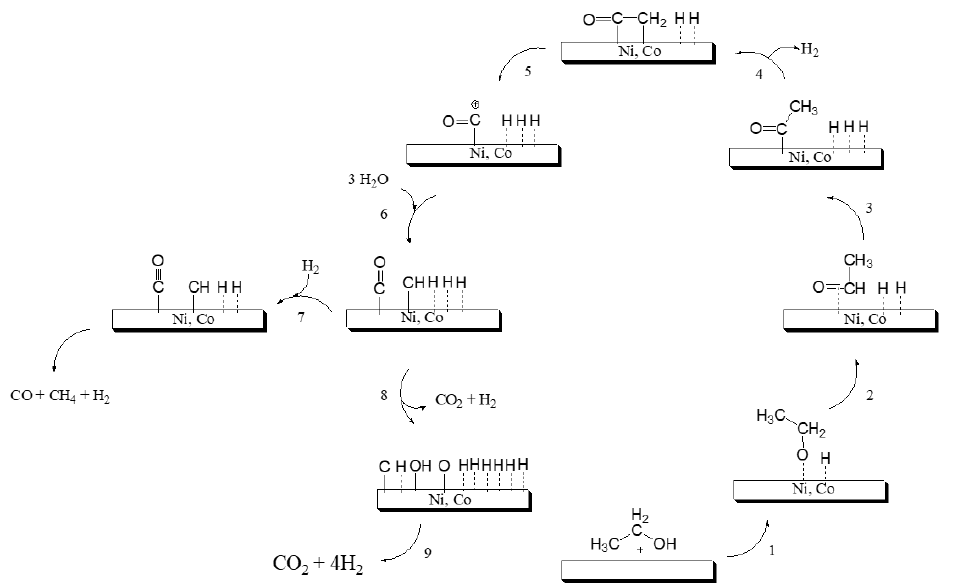
Figure 3. ESR reaction pathways as a function of temperature for metals such as nickel and cobalt (adapted from [65]).